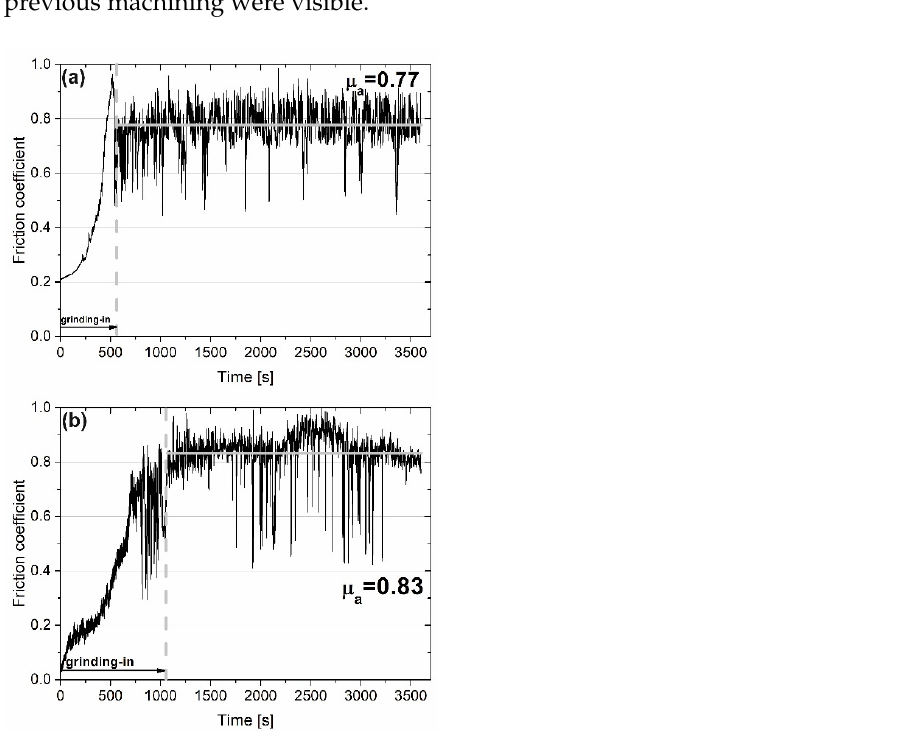
Figure 3. Surface condition of the counter-specimen mating with Ni-50%NiCr(80/20) ( a ) and Ni- 40%NiCr(80/20)-20%CaF 2 ( b ), after wear test conducted at room temperature. When the temperature of wear investigation increased to 200 °C, the course of the friction coefficient changed significantly (Figure 4). Grinding-in times were as follows: for the self-lubricating composite, approximately 1300 s; and for the composite without CaF 2 addition, approximately 300 s. The µ a value for the Ni–NiCr composite was 0.63, but after 2250 s it increased to 0.86. It may have been caused by adhesive wear, which meant that wear products were located between the mating parts. The µ a for the sample with the addition of CaF 2 was higher and equal to 0.69. Figure 5 shows the surface of the counter- specimens mated with samples. The signs of intensive abrasive wear were observed on the counter-specimen combined with the Ni–NiCr composite (Figure 5a). On the surface of the second counter-specimen, tribofilm was observed and, as a result, machining scratches were still visible after the wear test (Figure 5b).